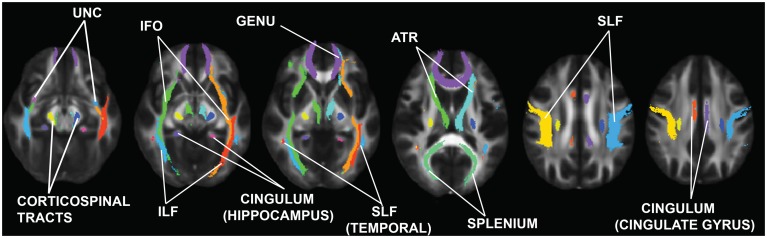
Regions of interest (ROIs) examined in this study. These ROIs were obtained from the Johns Hopkins University Probabilistic Tractography atlas (Wakana et al., 2004; Mori and Zhang, 2006). UNC, uncinate fasciculus; ILF, inferior longitudinal fasciculus; IFO, inferior fronto-occipital fasciculus; SLF, superior longitudinal fasciculus; ATR, anterior thalamic radiations.